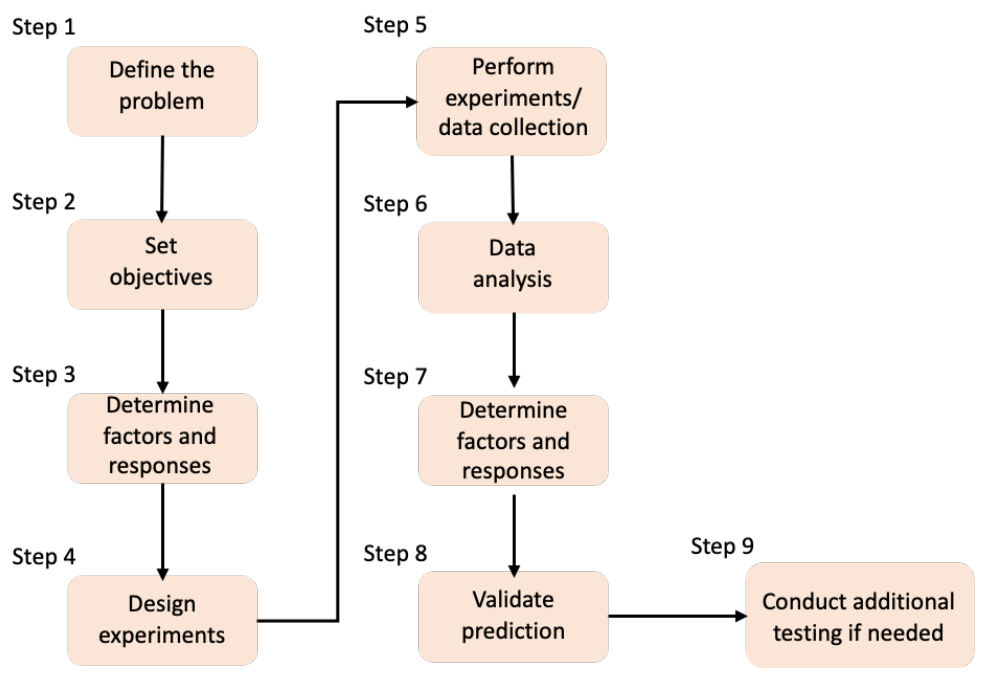
Figure 2. DoE workflow for the process optimisation.